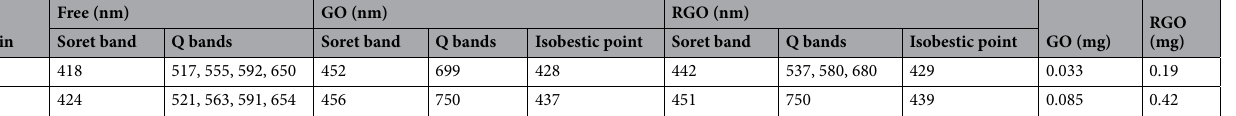
Table 1. Absorption properties of the free TPPH and TAPP and porphyrins adsorbed on GO and RGO. The summary of the maximum amount of the TAPP and TPPH adsorbed per 1 mg of GO and RGO sheets is provided in the last two